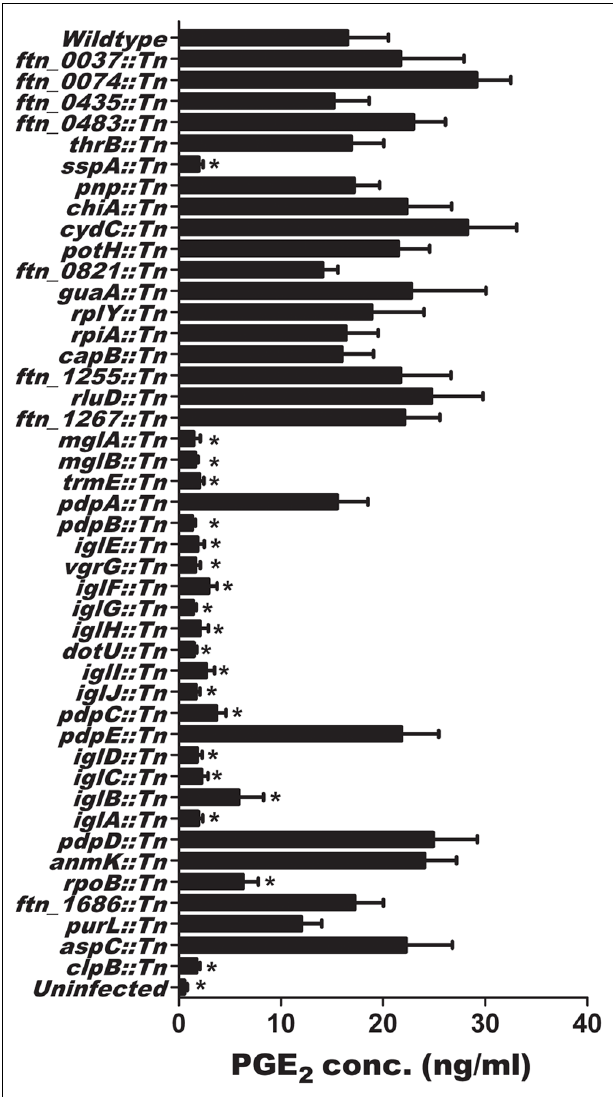
FIGURE 2 | Identification of U112 genes necessary for the induction of PGE 2 from bone marrow-derived macrophages (BMDMs). BMDMs were inoculated with F. novicida U112 or individual transposon insertion strains at an MOI of 200:1.Twenty-four hours after inoculation, supernatants were collected and PGE 2 concentration was determined. Each transposon insertion mutant strain was tested four times. Bars represents the mean of all independent transposon insertions mutants within the same gene ± SEM, Asterisk “*” denotes statistical difference ( p ≤ 0.05) from U112 inoculated BMDM ( n ≥ 4).